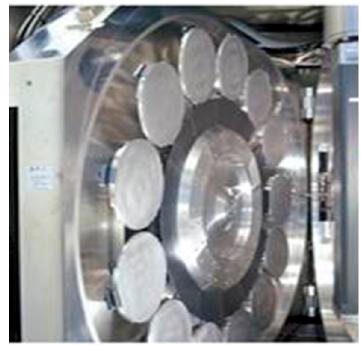
Figure 1. The rotating disk and wafer holders in the batch type ion implanters (courtesy of SMIT).